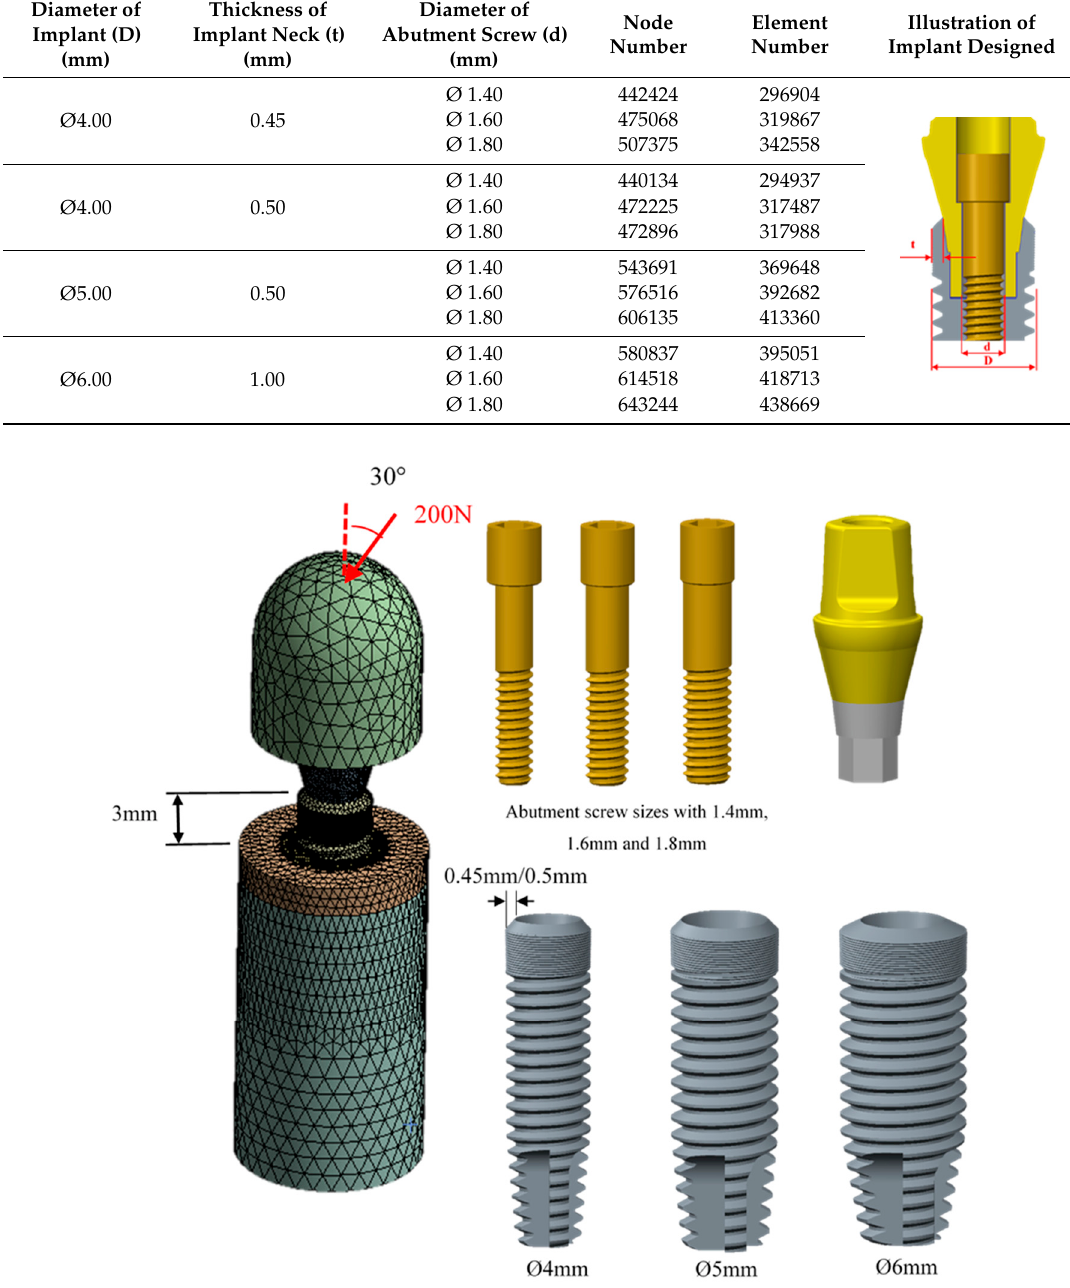
Figure 1. Solid models of our simulated models with different implant and abutment screw sizes in the right side and one of the simulated FE mesh models and loading condition in the left side.